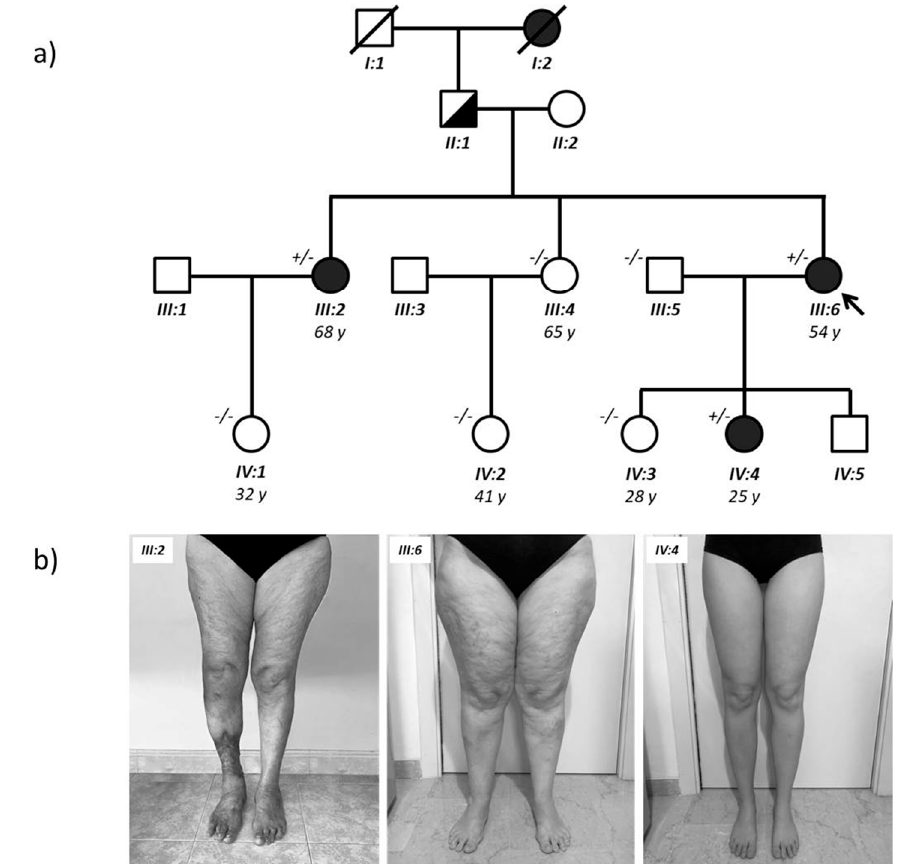
Figure 1. ( a ) Family tree; ( b ) Lipedema of the proband (III:6), her sister (III:2), and her daughter (IV:4). The right leg ulcer of proband’s sister (III:2) is the chronic result of a post traumatic post-phlebitic syndrome. WES analysis was performed on almost all family members of the last two generations and the AKR1C1 genotype is indicated next to the individual symbols (+/– are affected heterozygotes with the L213Q variant; –/– are unaffected wild-type homozygotes).